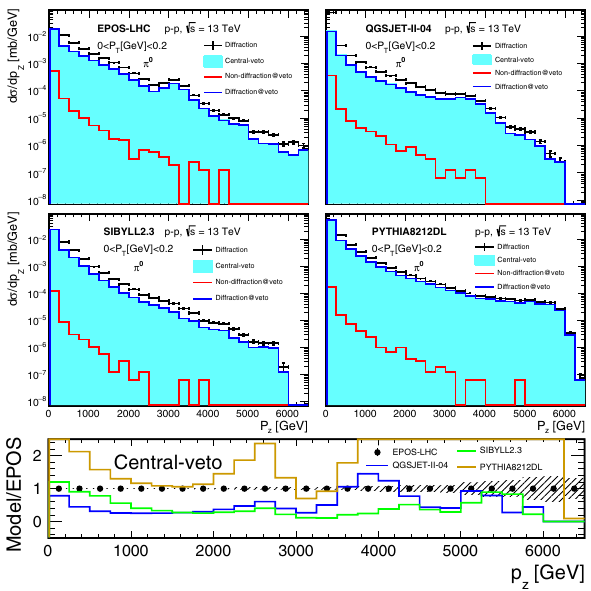
Fig. 9 π 0 spectra at 0 < p T < 0 . 2 GeV generated by EPOS-LHC, QGSJET-II-04, SYBILL 2.3, and PYTHIA 8212DL. The top four pan- els show the spectra of true diffraction ( black lines ) and diffractive- like events corresponding to central-veto selection ( filled gray areas ), which are defined as events without any p T > 100 MeV charged par- ticles at | η | < 2 . 5; in addition, the central-veto events were classified by nondiffraction ( red ) and diffraction ( blue ) again according to MC true information. The bottom plots show the ratios of the central-veto spectrum of each model to the central-veto spectrum of EPOS-LHC